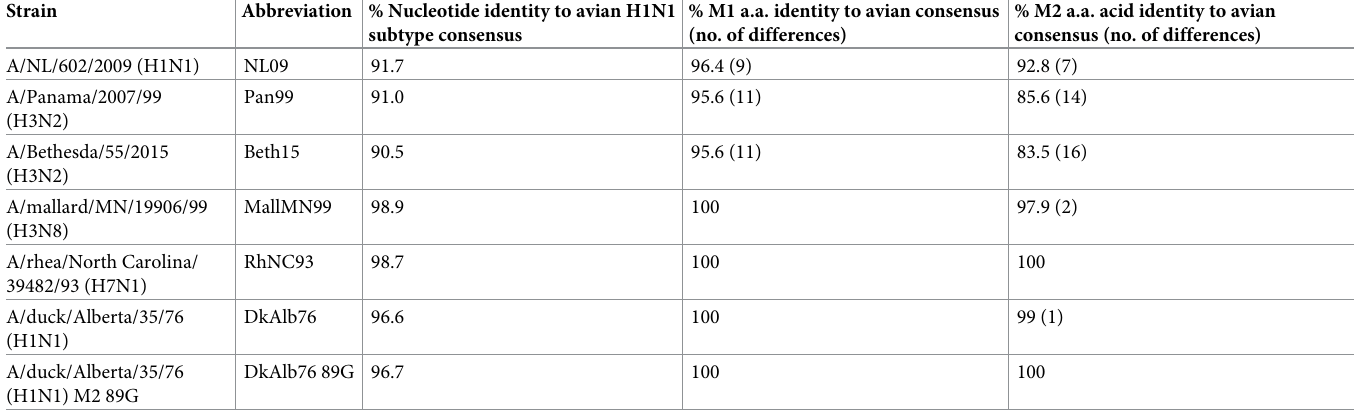
Table 1. Origin of IAV M segments used in